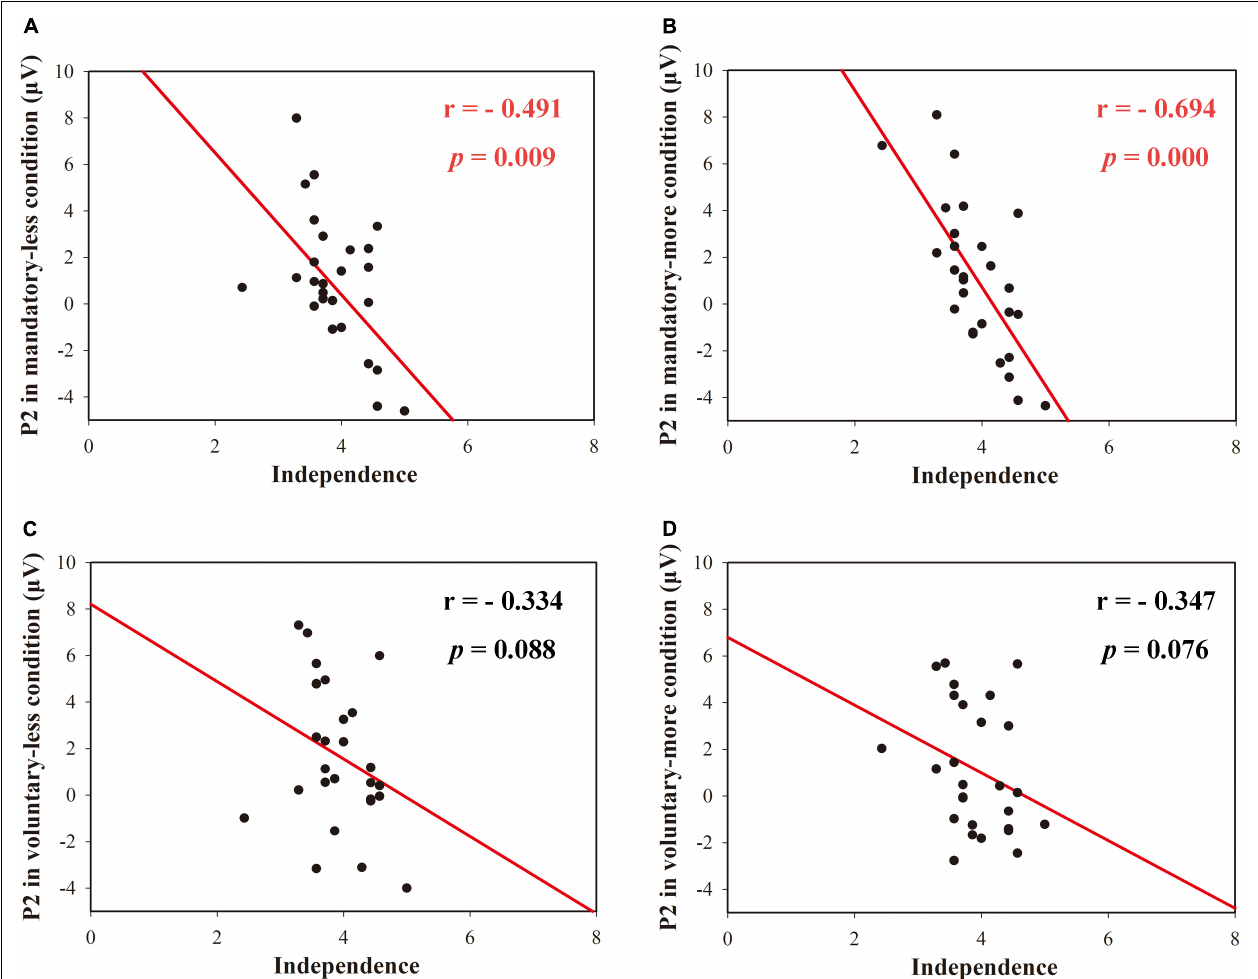
FIGURE 6 | The correlation between amplitudes of P2 in four conditions and independence. Correlation between (A) P2 in the mandatory-less condition and independence; (B) P2 in the mandatory-more condition and independence; (C) P2 in the voluntary-less condition and independence; (D) P2 in the voluntary-more condition and